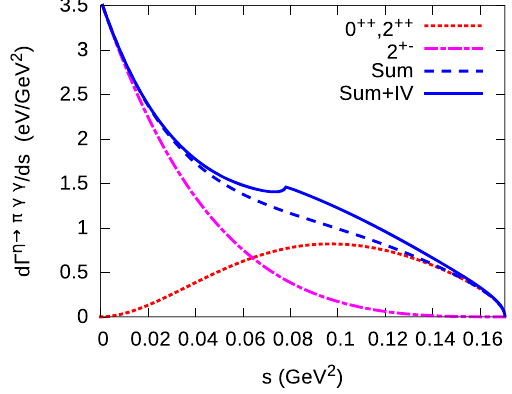
Fig. 9 Contributions to the η → π 0 γγ energy distribution from the amplitudes fitted in the scattering region. Dotted line (red): S -wave (isospinconserving)and2 ++ D -wave,dash-dottedline(magenta):2 +− D -wave, dashed line: sum of the S and D waves, solid line: sum includ- ing the isospin violating amplitude ˜ l 0 ++